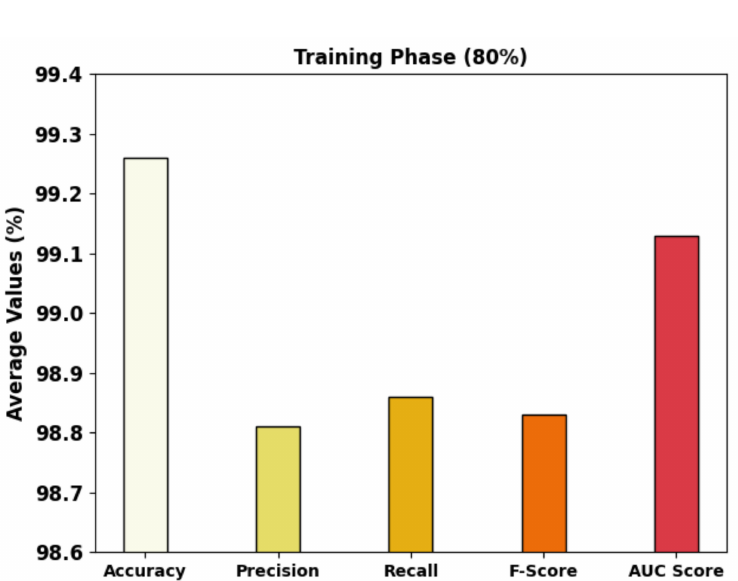
Figure 5. Average analysis of MRFOTL-GCDC system in 80% of the TR